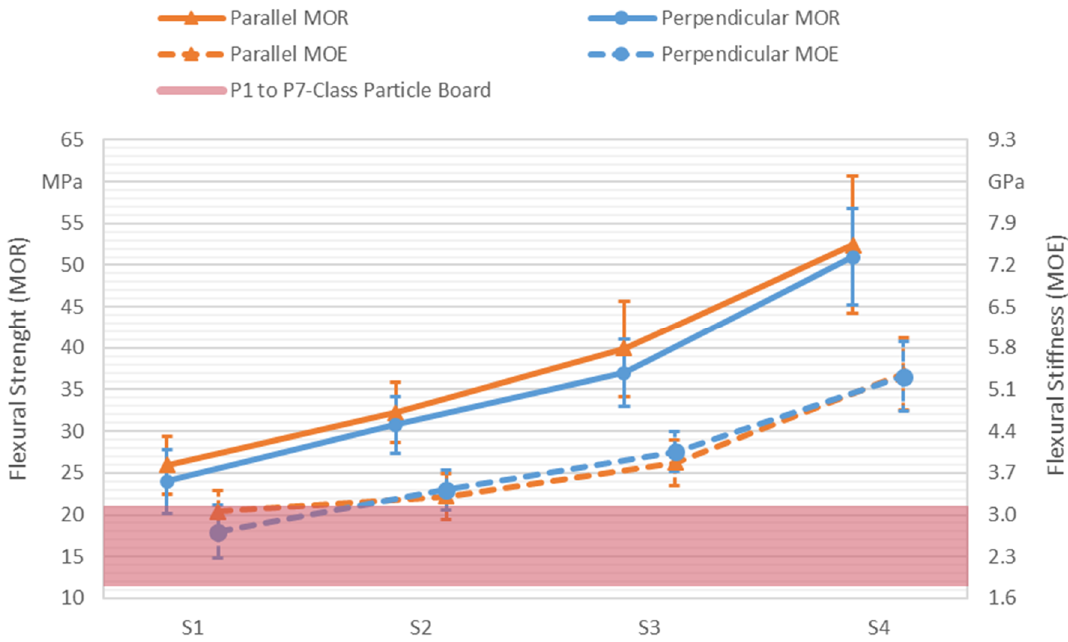
Figure 6. Results of flexural testing. Solid lines display values of flexural strength (modulus of rupture (MOR)) and dashed lines values of flexural stiffness (modulus of elasticity (MOE)). Orange triangles indicate the parallel orientations of specimens, and blue circles represent the perpendicular orientations of specimens. The red area contains requirements for P1 to P7 particle boards.